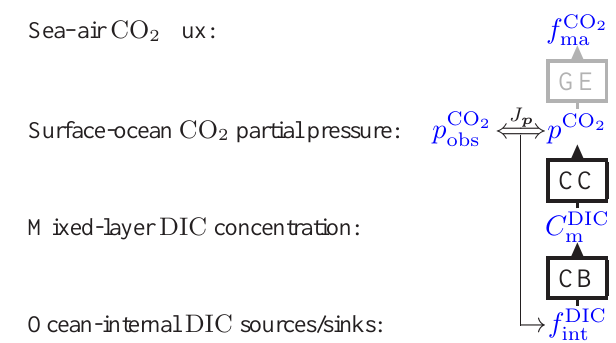
Fig. 1. Illustration of the inverse procedure in our main case (run Figure 1. Illustration of the inverse procedure in our main case (run SFC ); boxes denote the process representations causally linking SFC ): Boxes denote the process representations causally linking quantities from bottom to top: mixed-layer carbon budget (CB), car- quantities from bottom to top: Mixed-layer carbon budget (CB), bonate chemistry (CC), solubility and sea–air gas exchange (GE). Carbonate chemistry (CC), Solubility and sea–air gas exchange The double arrow symbolizes the matching between observed and (GE). The double arrow symbolizes the matching between observed modelled CO 2 partial pressure, as gauged by the cost function J p . and modelled CO 2 partial pressure, as gauged by the cost function The thin arrow indicates the adjustments of the unknown ocean- J p . The thin arrow indicates the adjustments of the unknown ocean- internal carbon sources/sinks, undertaken to minimize the model– internal carbon sources/sinks done to minimize the model-data mis- data mismatch (see Rödenbeck et al. (2013) for full match (see R¨odenbeck et al. (2013) for full details).